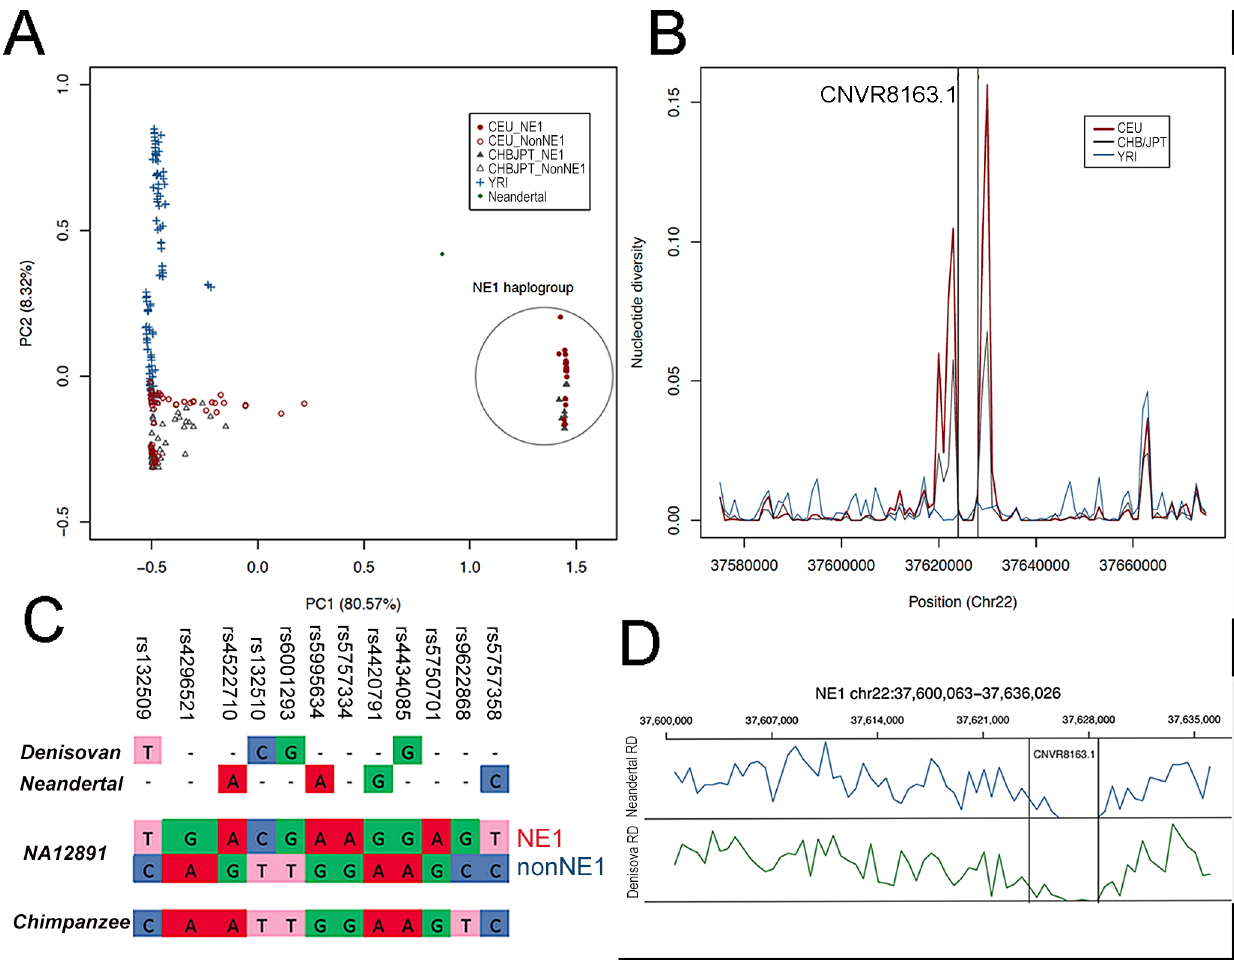
Figure 2. NE1 haplotypes share ancestry with Neandertals. (A) The principal component analysis (PCA) of the SNP haplotypes from CEU, CHB/ JPT and YRI populations indicates population substructure between African and Eurasian populations, as well as within Eurasians. Please note the separation of NE1 and NonNE1 haplogroup. (B) Nucleotide diversity ( p ) within populations is depicted. For most of the genomic segments, p is higher within the YRI population ( blue line ) when compared to Eurasian populations ( red line ). However, there is an increase of p for Eurasian populations at the NE1 locus, surrounding the CNVR 8163.1 deletion. (C) The evaluation of 12 SNPs (that separate NE1 and nonNE1 haplogroups) in the CEU sample, NA12891, as well as Denisovan, Neandertal and chimpanzee consensus haplotypes. (D) Normalized read-depth of the Neandertal and Denisovan sequences across the NE1 locus. Please note the drop of the sequence read-depth to 0 for the region corresponding to the human CNVR8163.1 deletion.